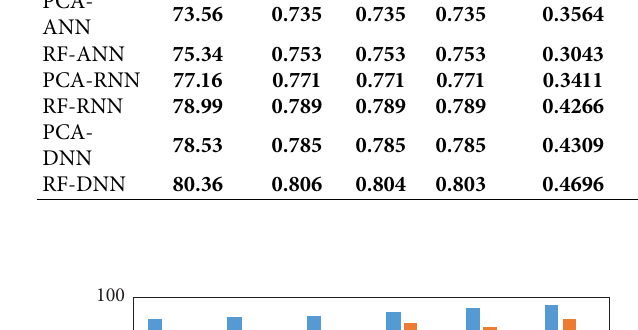
Table 4: Validation of the proposed model for 30 features. Model